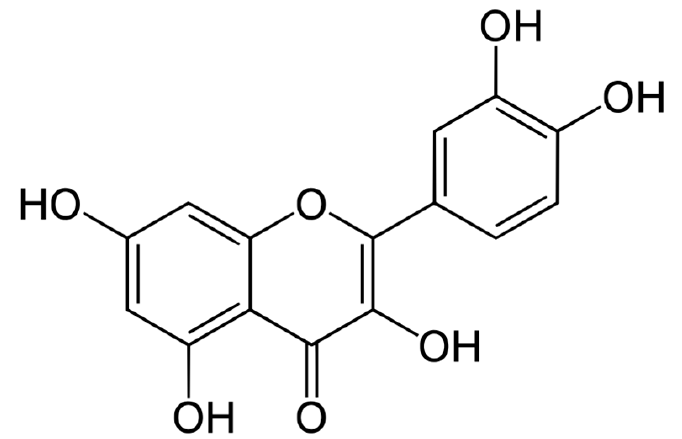
Figure 1. Chemical structure of quercetin.